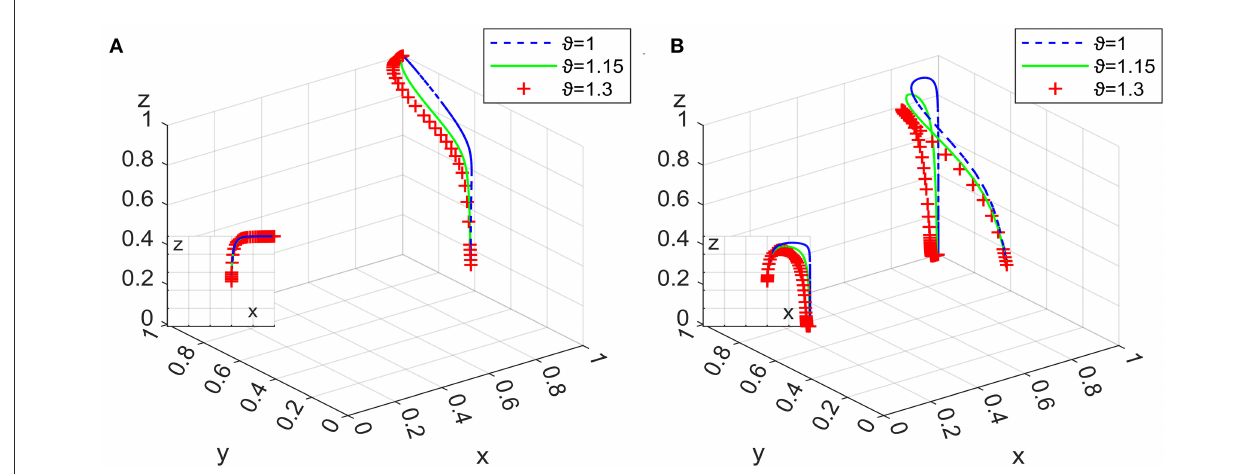
FIGURE9 Impact on subsidy intensity for domestic enterprises in system L (A) and system P (B) .